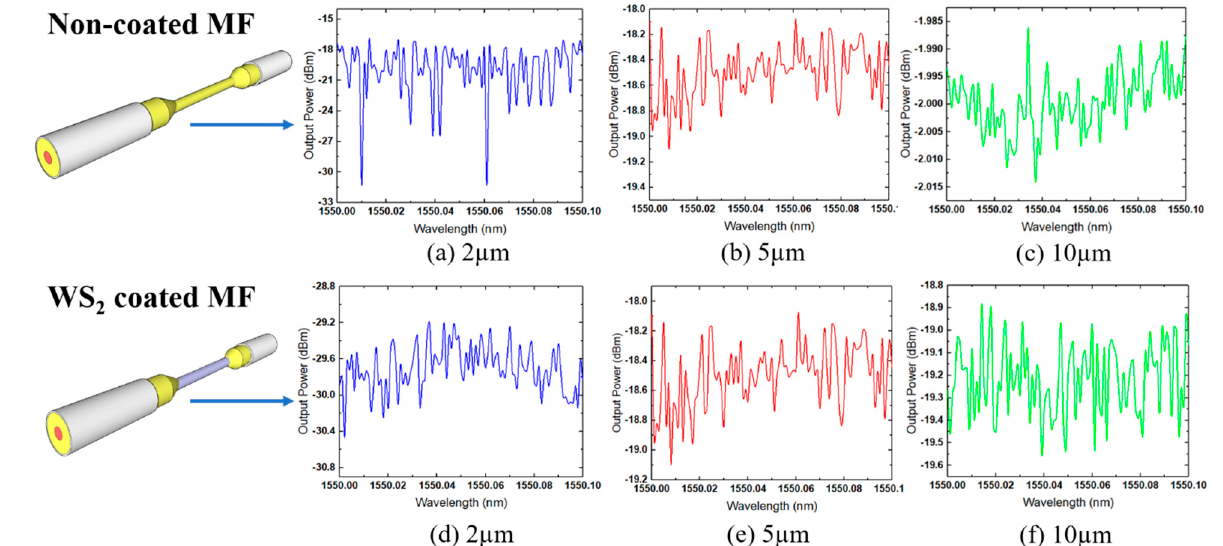
Figure 6. Non-coated MF transmission modes ( a–c ) and coated MF transmission modes ( d–f ) of 2, 5, and 10 µm.